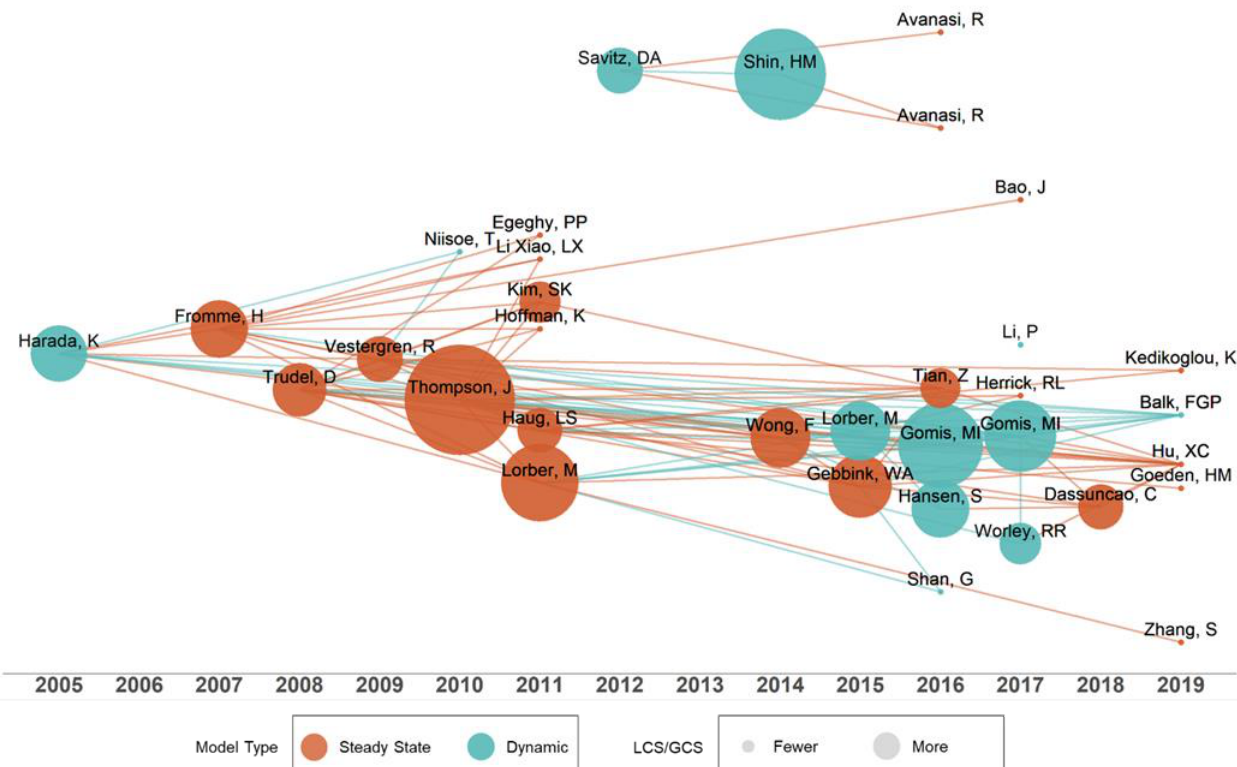
Figure 5. Historiograph of human one compartment TK models used for PFAS (2005 – 2019) Figure 5. [14,19,25,61,65 – 94] .